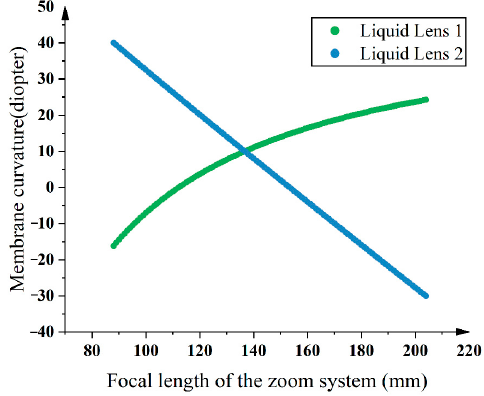
Figure 12. Zoom curves.